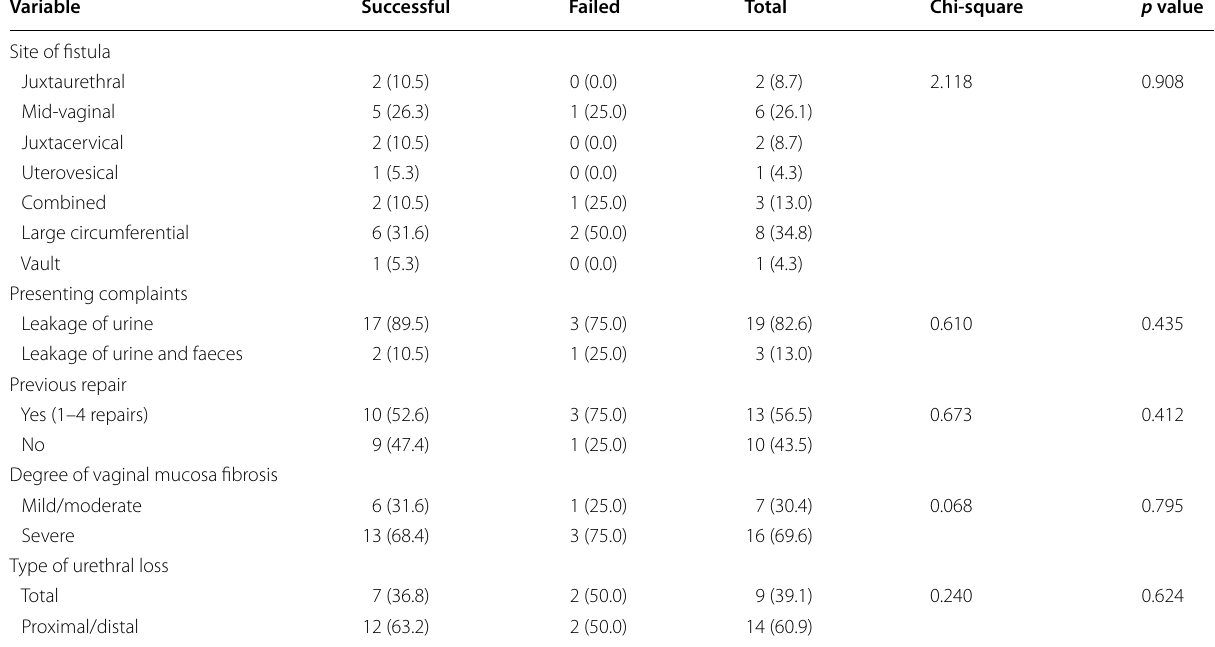
Table 3 Factors associated with successful urethral reconstruction Variable